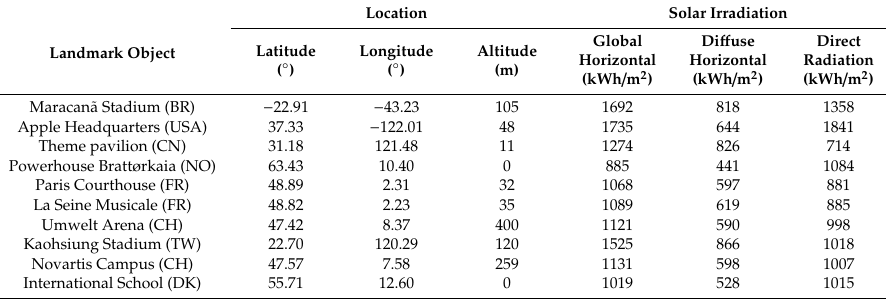
Table 1. Location and solar radiation data for the examined